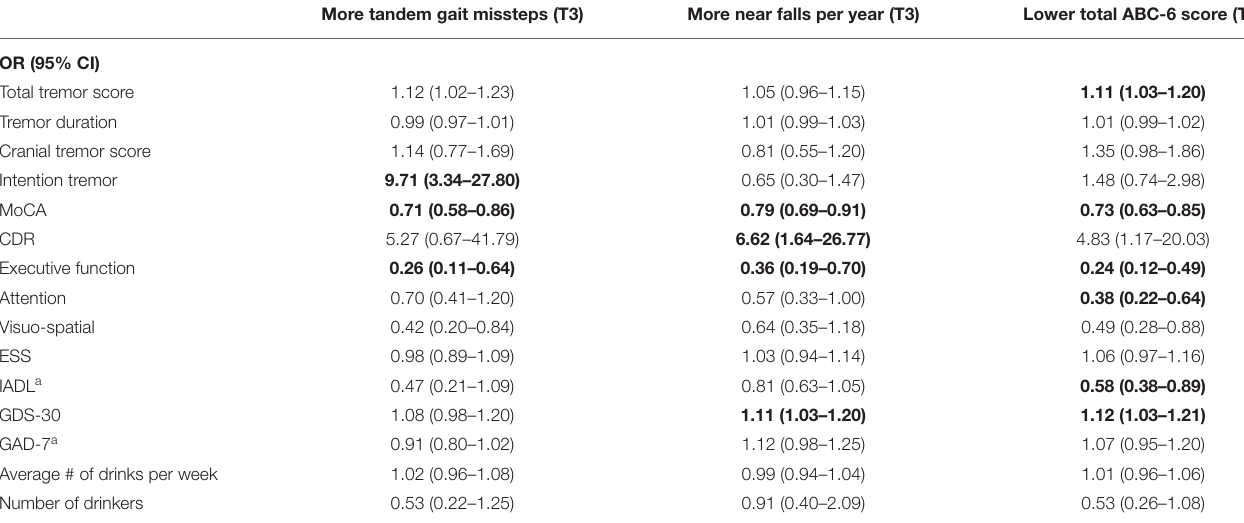
TABLE 3C | Unadjusted logistic regression models: Baseline characteristics as predictors of T3 gait and balance outcomes (based on available literature). More tandem gait missteps (T3) Lower total ABC-6 score (T3)